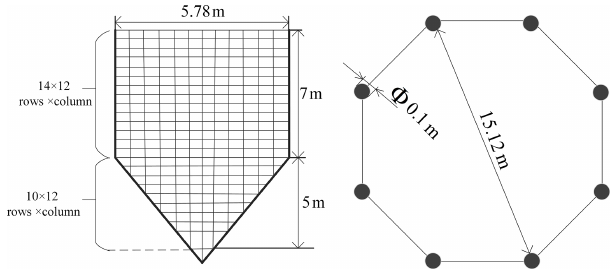
Figure 3. Space netted pocket system